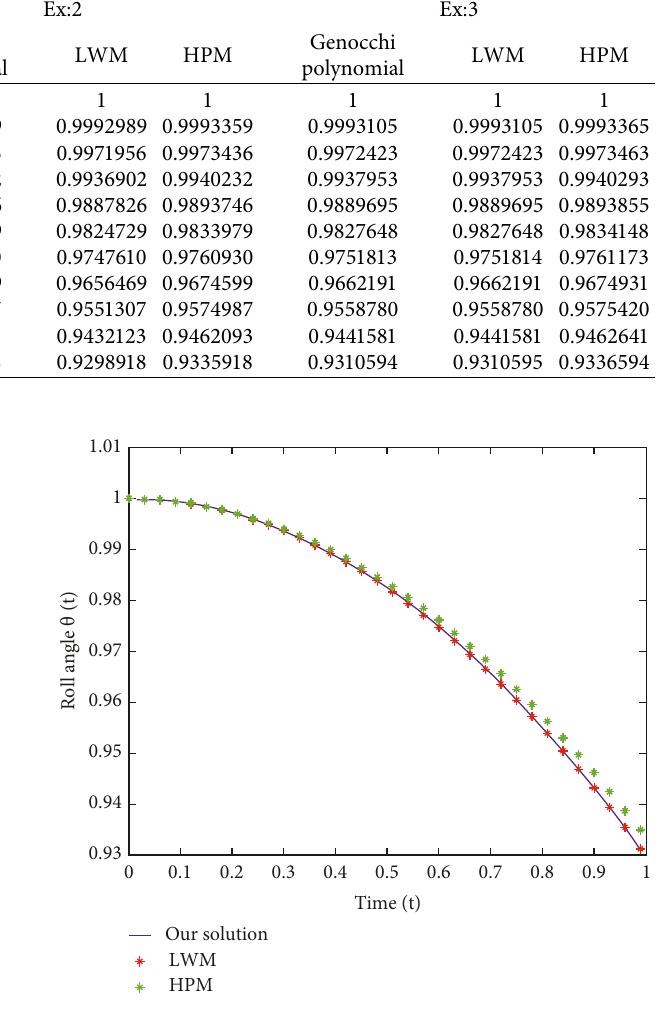
Figure 1: Comparative study of Genocchi polynomial, LWM, and HPM for roll angle with respect to the time t (in sec) for Ex.1.